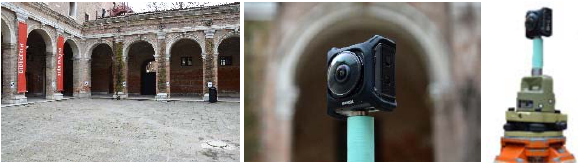
Figure 2. The acquisition phase with the KM360 on the topographic tripod.